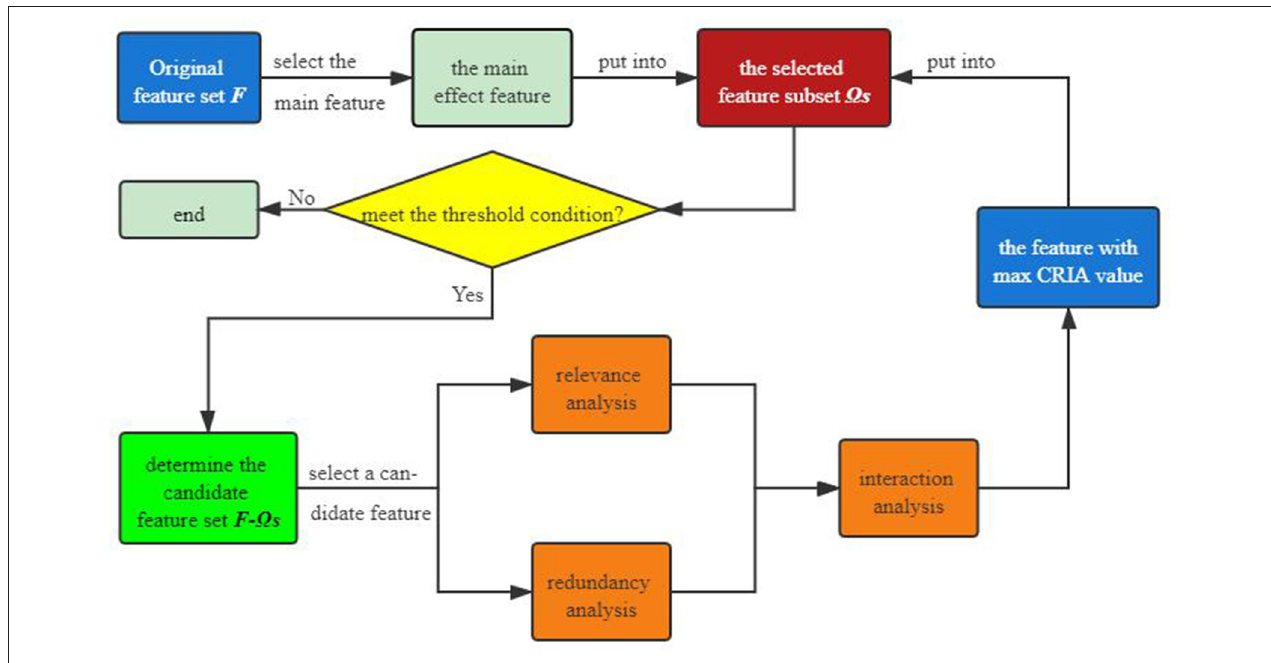
FIGURE 1 | General flow chart of the proposed algorithm.